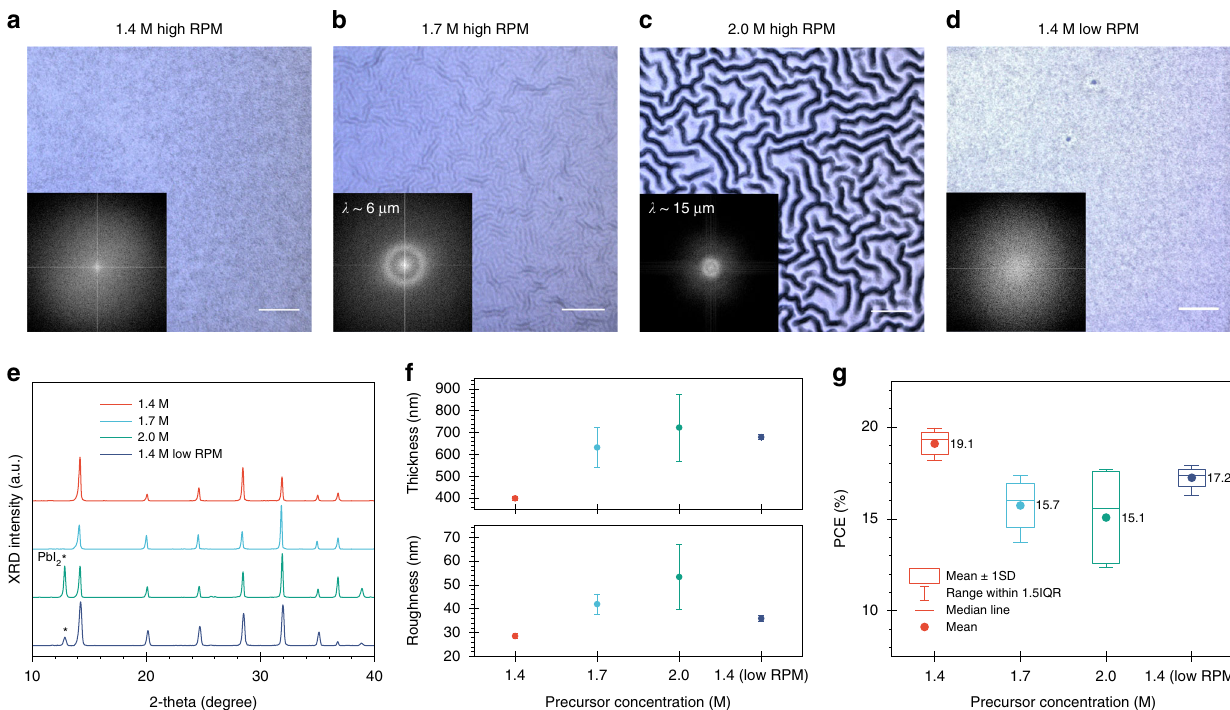
Fig. 1 Morphology and photovoltaic performance of perovskite fi lms prepared by different precursor concentrations. a – d Optical microscope images and corresponding fast Fourier transform (FFT) of perovskite fi lms prepared by different methods ( λ is the wrinkling wavelength). Scale bar: 10 µ m. e XRD patterns and f surface morphology of perovskite fi lms. Error bars are standard deviations of ten locations in SEM cross-sectional images for thickness and of root mean squared (RMS) analysis from AFM images for roughness. g Corresponding PCE values (12 devices each).